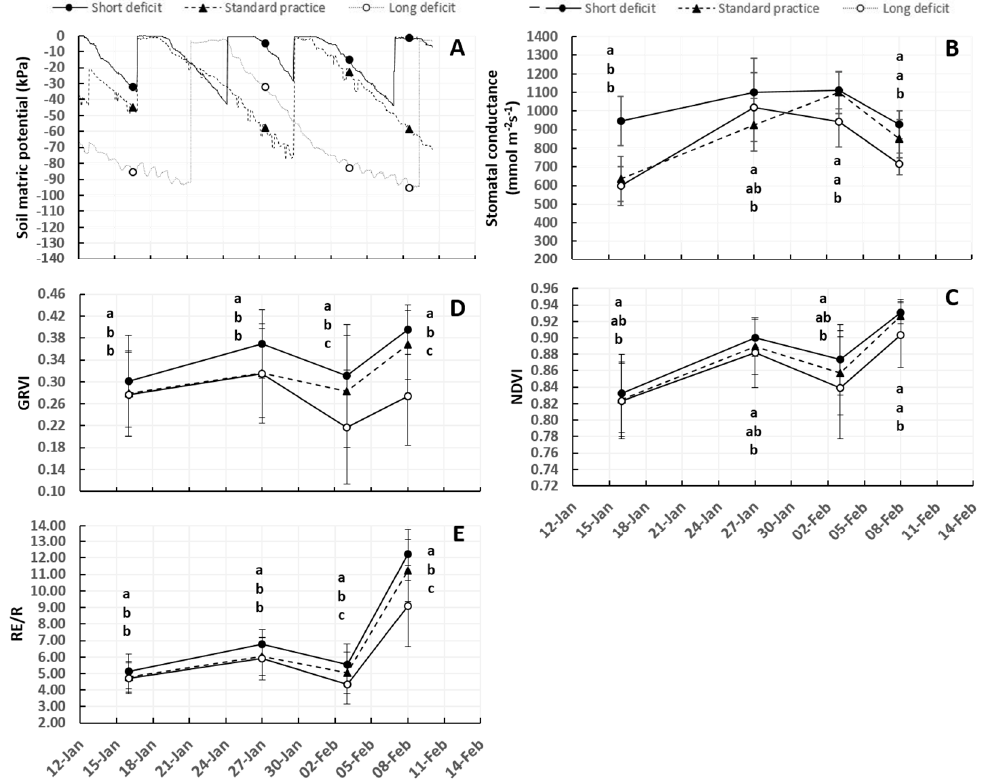
Figure 3. Mean values of ( A ) soil matric potential, ( B ) stomatal conductance and the multispectral vegetation indices, ( C ) GRVI, ( D ) NDVI and ( E ) RE/R for each irrigation treatment and measurement date during the 2016/17 growing season. Graph A also shows the evolution of the soil matric potential for the period when all the measurements were taken (from 15 January to 08 February 2017). Dates when soil matric potential returns to values < − 10 kPa are indicative of an irrigation event. Different letters within a measurement date indicate statistical significant differences between treatments at p < 0.05. The letter on the top refers to the highest value whereas the letter on the bottom refers to the lowest. Vertical bars indicate the standard deviation for each treatment and date.